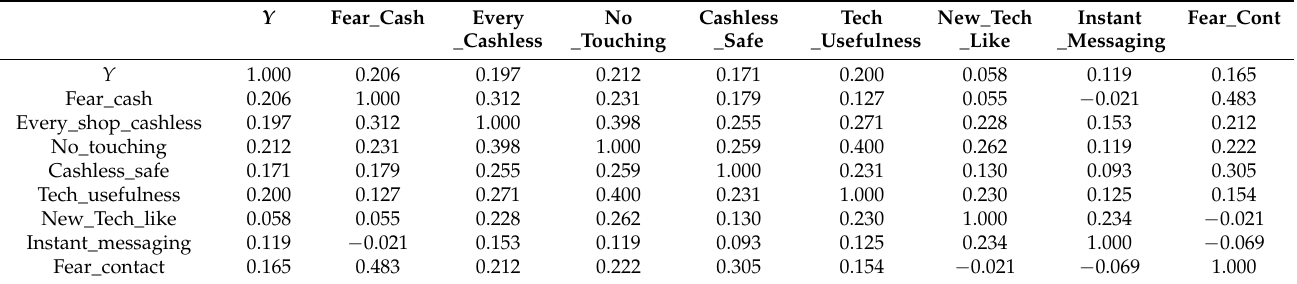
Table 4. Correlations between